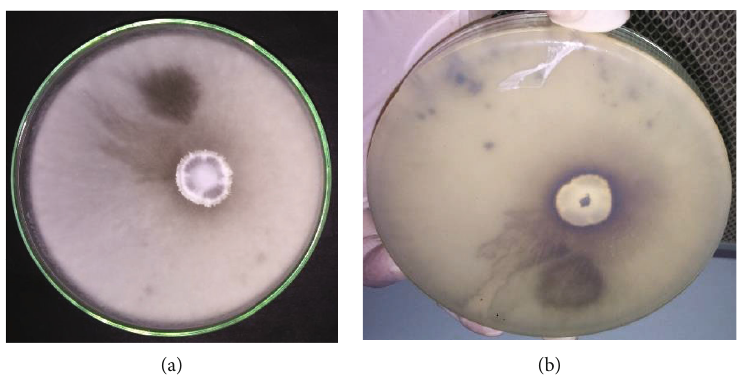
Figure 1: Culture of P. sordida on PDA after 7 days of inoculation: (a) front side; (b) rear